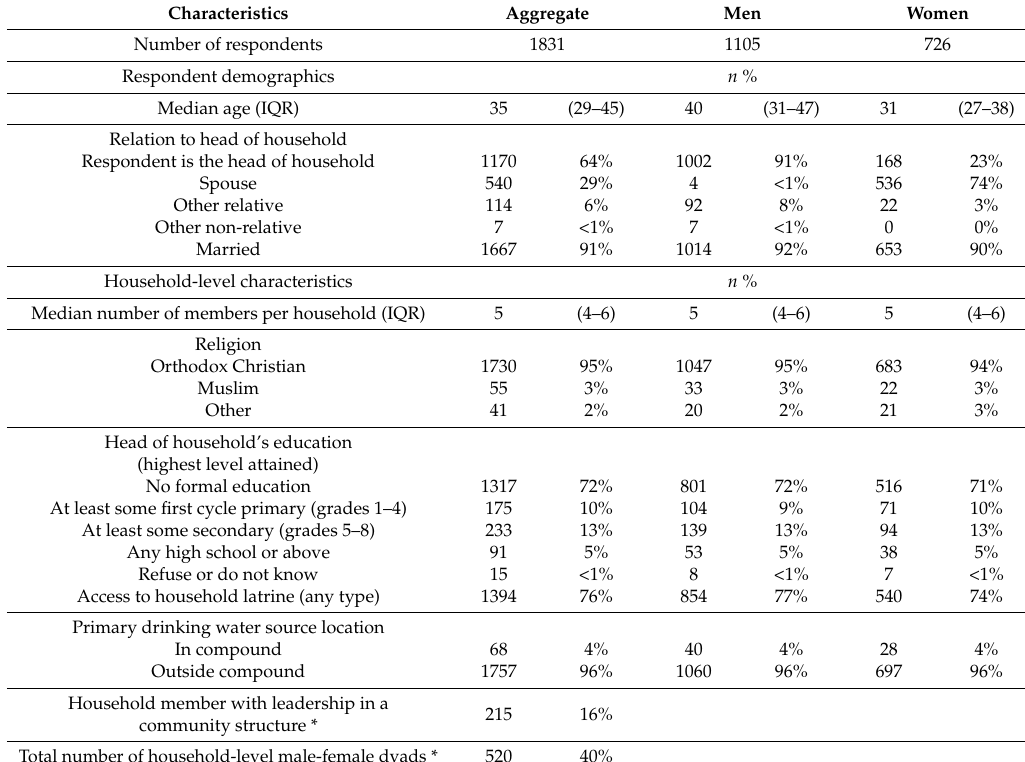
Table 2. Respondent demographics, household- and cluster-level characteristics, by gender.